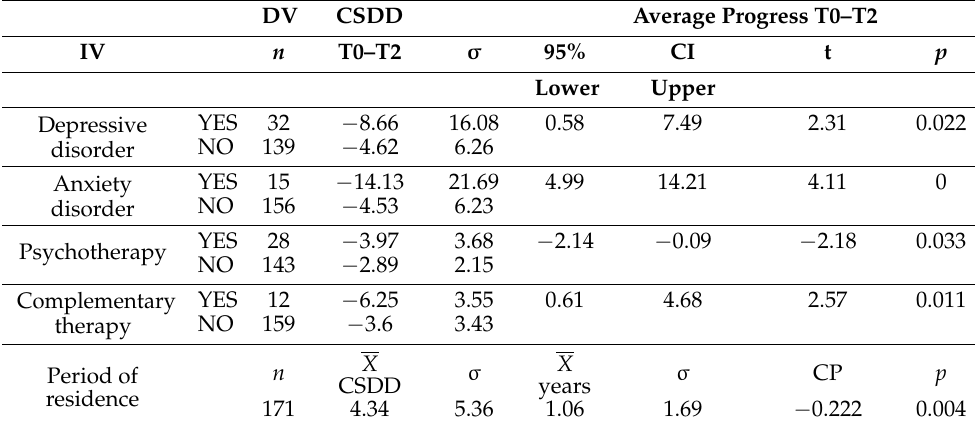
Table 4. CDSS versus disorders, therapies, and time of